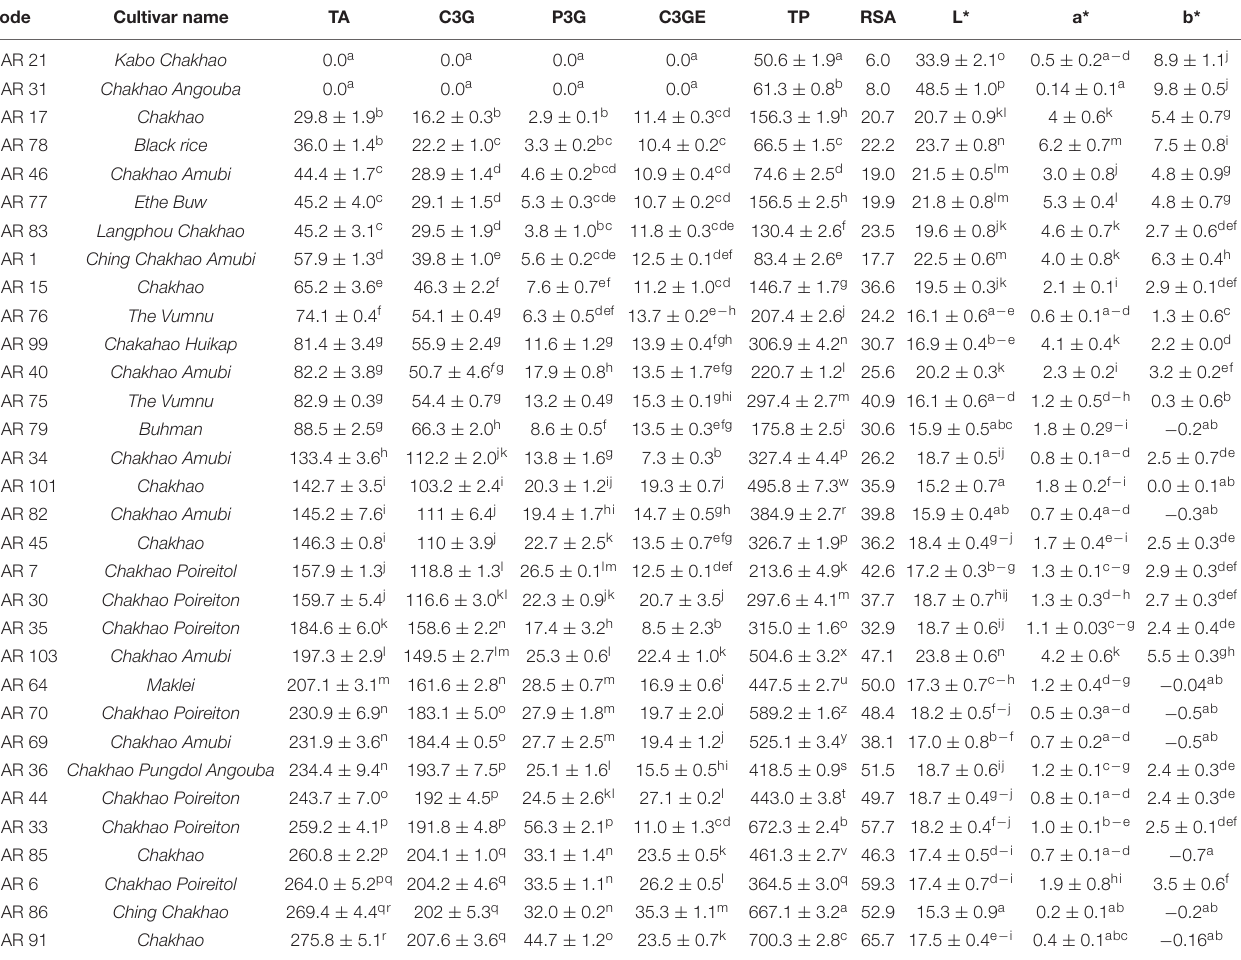
TA, total anthocyanin in mg.100g − 1 dry weight (DW); C3G, cyanidin-3-O-glucoside in mg.100g − 1 DW; P3G, peonidin-3-O-glucoside mg.100g − 1 DW; C3GE, cyanidin- 3-glucoside equivalents in mg.100g − 1 DW; TP, total phenolics in mg gallic acid equivalent (GAE) 100g − 1 ; RSA, radical scavenging activity in percentage; L*, a*, b* are CIELAB color scales. Means with different letter(s) indicate significant difference between genotypes at p = 0.05 by Duncan’s multiple-range test.